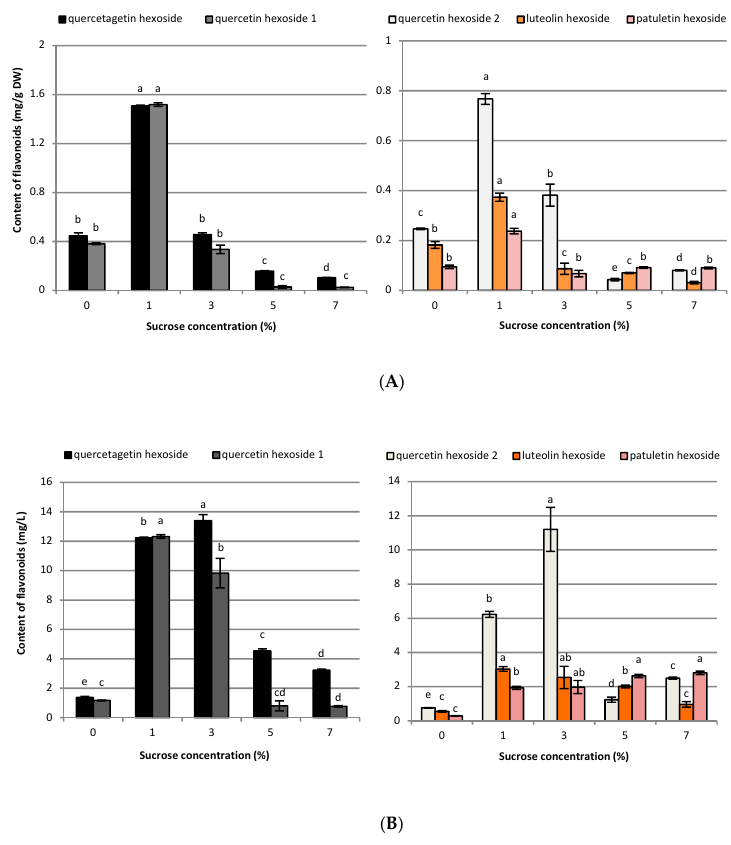
Figure 6. Effect of sucrose concentration (0–7%) on flavonoid contents in ( A ) mg g − 1 DW and ( B ) mg L − 1 in R. carthamoides transformed roots cultured in 50 mL of liquid WPM medium in a 300 mL Erlenmeyer flask, in light conditions (16/8-h light/dark photoperiod) on a rotary shaker at 80 rpm. The results are means values ± SE ( n = 9). Different letters for the same metabolite signify significant differences between the sucrose concentrations ( p < 0.05).